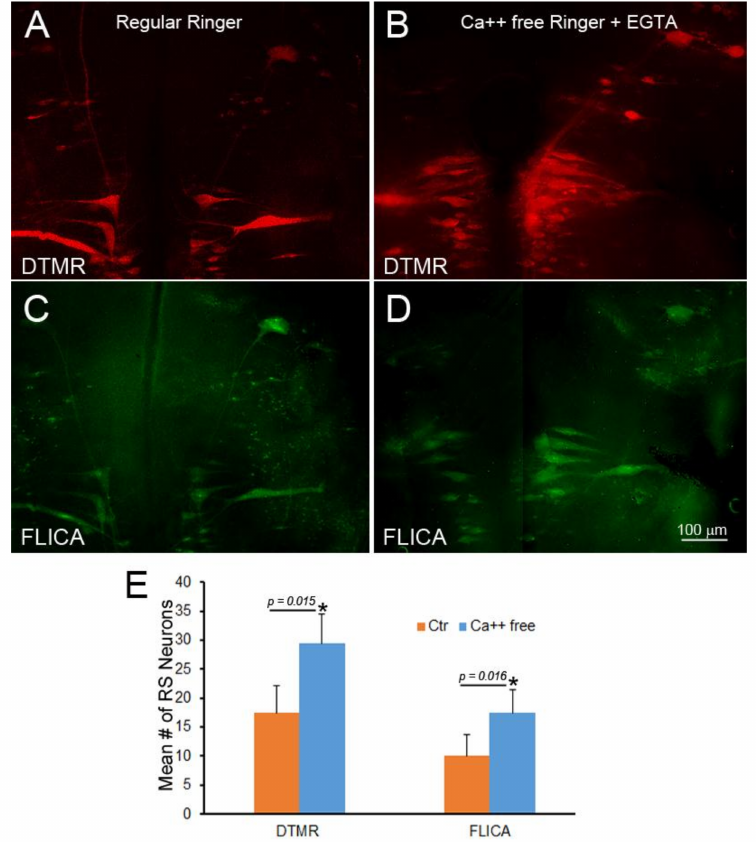
Figure 11. Failure of Ca ++ chelation to protect against retrograde apoptotic signaling. Spinal cord TX was performed in Ringer’s solution containing 0 mM Ca ++ and 1mM EGTA. After 2 h, the wound was closed, and the animals were returned to fresh water. At 24 h post-TX, DTMR was applied to the TX site to label late-sealing axons and their neurons. The animals survived 2 weeks, and their brains were processed by FLICA. ( A ) The brainstem of an animal with late-sealing axons labeled with DTMR; ( B ) similar to ( A ), but treated with normal Ringer’s solution instead of 0 mM Ca ++ /EGTA; ( C , D ) FLICA labeling of neurons in ( A , B ), respectively; ( E ) eliminating Ca ++ increased the number of axons with delayed sealing, but increased apoptotic